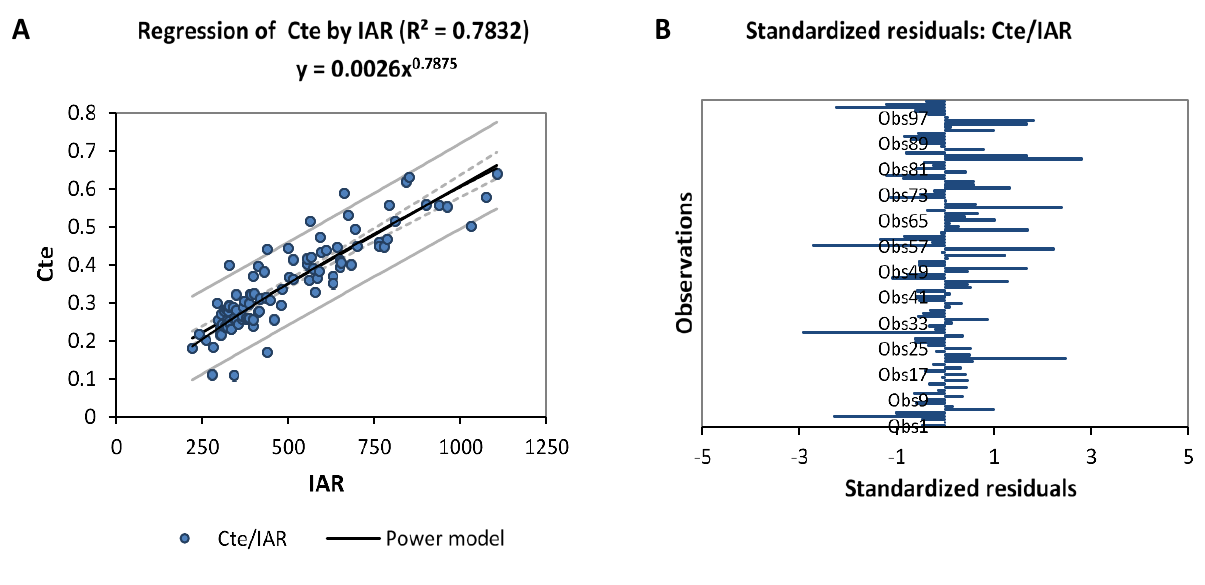
Figure 7. Nonlinear regression graph ( A ), followed by standardized residual analysis histogram ( B ) between inter-annual rainfall (IAR) and Cte data. Real Inter-annual rainfall-runoff residuals (IARR), estimated inter-annual rainfall-runoff residuals by ANN 1 (EIRR).